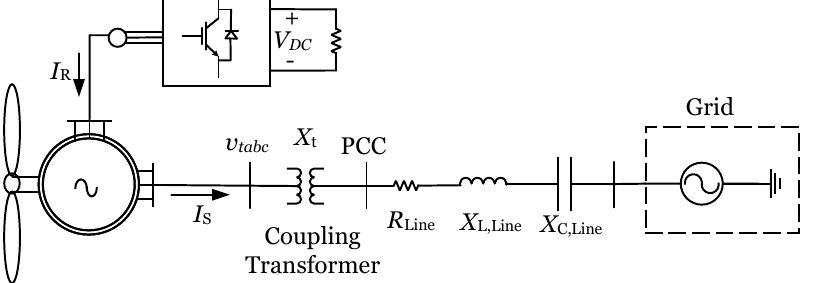
Figure 3. Schematic diagram of a Type II wind